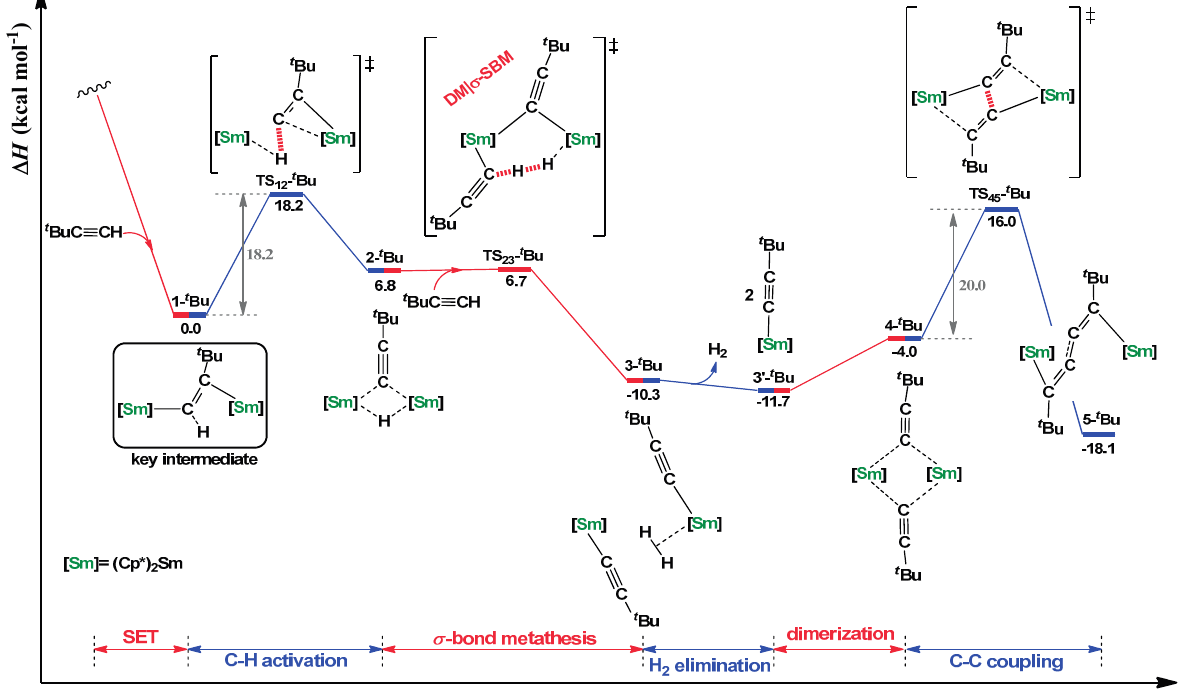
Figure 6. Enthalpy energy Δ H (kcal·mol − 1 ) profile for the formation of the uncoupled alkynide complex using t BuC ≡ CH as substrate and (Cp * ) 2 Sm as a precursor. Cp * ligands are omitted for